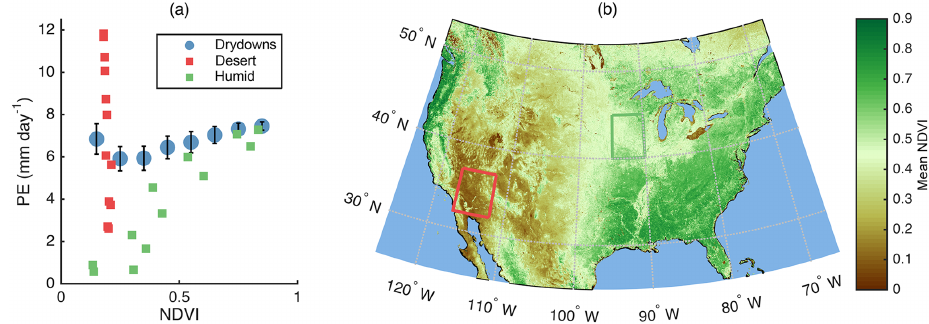
Figure 8. (a) Circles show median PE as a function of eight equal-width bins of increasing NDVI for all drydowns used in this study. Squares show average monthly relationships between PE and NDVI in two regions. (b) Extent indicators show locations of two regions.